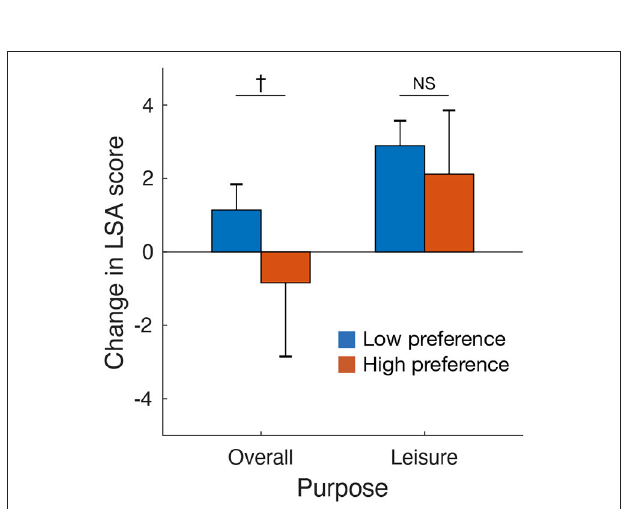
FIGURE 4 | Impacts of preferences for online services to obtain food on desire for going-out activities in the future after the end of the COVID-19 pandemic. Participants were classified into high ( N = 602) and low ( N = 95) preference groups according to their usage history of online services to obtain food (e.g., food delivery) during the ED. Error bars represent 95% confidence intervals. † P < 0.1; NS, not